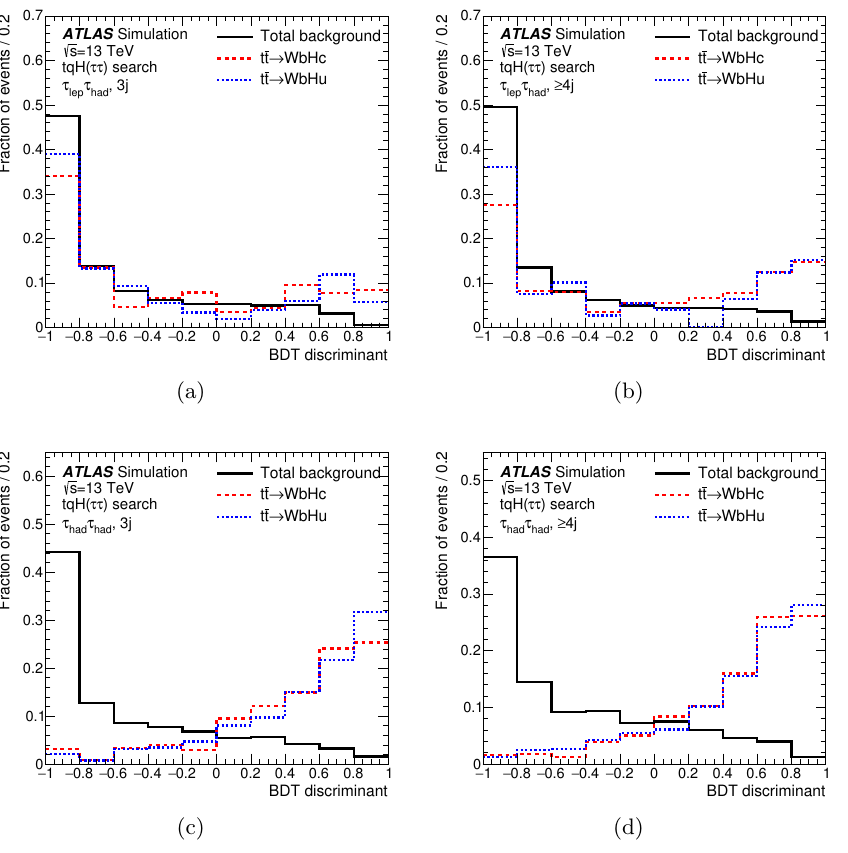
Figure 6 . tqH ( (cid:28)(cid:28) ) search: comparison of the distributions of the BDT discriminant after pre- selection of the t (cid:22) t ! WbHc (red dashed) and t (cid:22) t ! WbHu (blue dotted) signals, and the total background (black solid) in the di(cid:11)erent search regions considered: (a) ( (cid:28) lep (cid:28) had , 3j), (b) ( (cid:28) lep (cid:28) had , (cid:21) 4j), (c) ( (cid:28) had (cid:28) had , 3j), and (d) ( (cid:28) had (cid:28) had , (cid:21) 4j). jet energy scale, whose uncertainty dependence on jet p and (cid:17) , jet (cid:13)avour, and pile-up T treatment, is split into 21 uncorrelated components that are treated independently